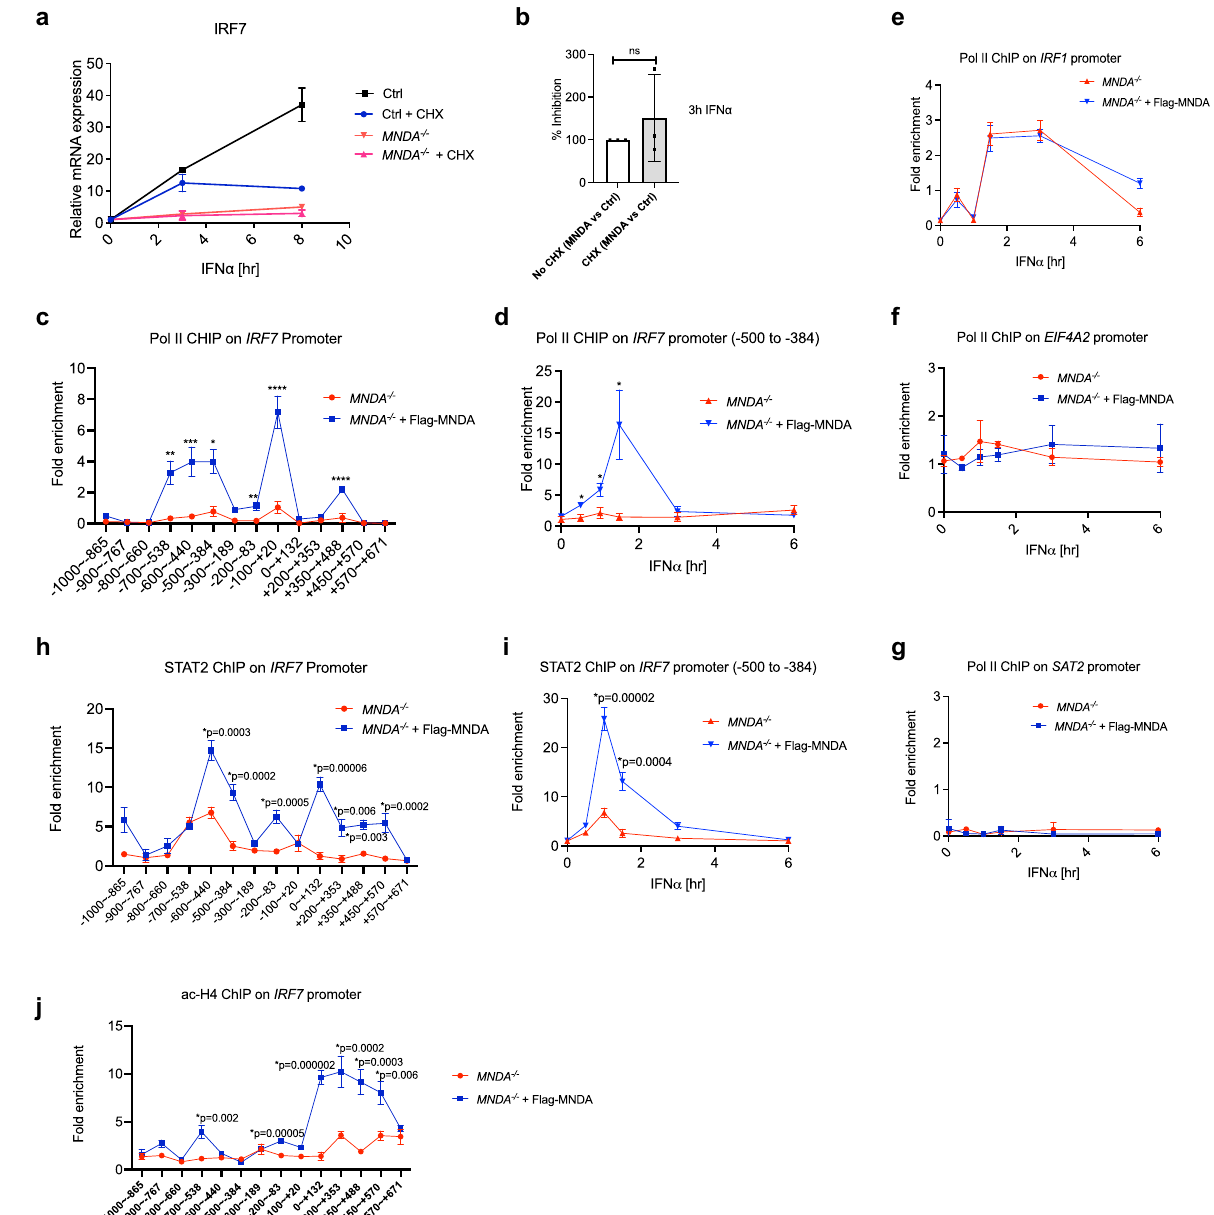
Fig. 6 IFN α -dependent Pol II and STAT2 recruitment to the IRF7 promoter is MNDA-dependent. a , b Three THP-1 MNDA − / − or control (Ctrl) clones were pre-treated for 1 h with cycloheximide (CHX) as indicated followed by IFN α (1000 U/ml) stimulation for the indicated times. Quantitative PCR analysis of IRF7 mRNA is shown for the average of three cell lines ( a ) and as percentage of inhibition of IRF7 mRNA seen in the MNDA − / − cells versus control cells, setting the amount of inhibition in the absence of CHX as 100% ( b ). For ( a , b ), data are mean ± SD of triplicate samples and are representative of three independent experiments; two tailed unpaired Students t test; signi fi cance is de fi ned as p < 0.05 between groups; ns indicates not signi fi cant ( c ) Chromatin immunoprecipitation (ChIP) of the recruitment of RNA Pol II to the IRF7 promoter between the region of nucleotides − 1000 to + 671, using primer sets to amplify the speci fi c regions indicated in MNDA − / − cells expressing empty lentiviral vector or vector encoding Flag-MNDA. Cells were stimulated with IFN α (1000 U/ml) for 1 hr. d – g Cells were treated with IFN α (1000 U/ml) for the indicated times prior to ChIP analysis. ChIP of the recruitment of RNA Pol II to the − 500 to − 384 region of the IRF7 promoter ( d ), the IRF1 promoter ( e ), the EIF4A2 promoter ( f ) and the SAT2 promoter ( g ) in MNDA − / − cells expressing empty lentiviral vector or vector encoding Flag-MNDA. h ChIP of the recruitment of STAT2 to the IRF7 promoter between the region of nucleotides − 1000 to + 671, using primer sets as per ( c ). Cells were stimulated with IFN α (1000 U/ml) for 1 hr. i ChIP of the recruitment of STAT2 to the − 500 to − 384 region of the IRF7 promoter. Cells were treated with IFN α (1000 U/ml) for the indicated times. j ChIP of the recruitment of Histone H4K5,8,12,16ac (ac-H4) to the IRF7 promoter between the region of nucleotides − 1000 to + 671, using primer sets as per ( c ). Cells were stimulated with IFN α (1000 U/ml) for 1 hr. For ( c – j ), data are presented as mean ± SEM of three independent experiments, each done with technical duplicates; two tailed unpaired Students t test; * p < 0.05 indicates signi fi cance compared to respective groups; p values for ( c ) are * p = 0.02, ** p = 0.003, *** p = 0.004, **** p = 0.0002; for ( d ) are * p = 0.02. ChIP antibody isotype controls for ( c – e , h – j ) are shown in Supplementary Fig. 9.